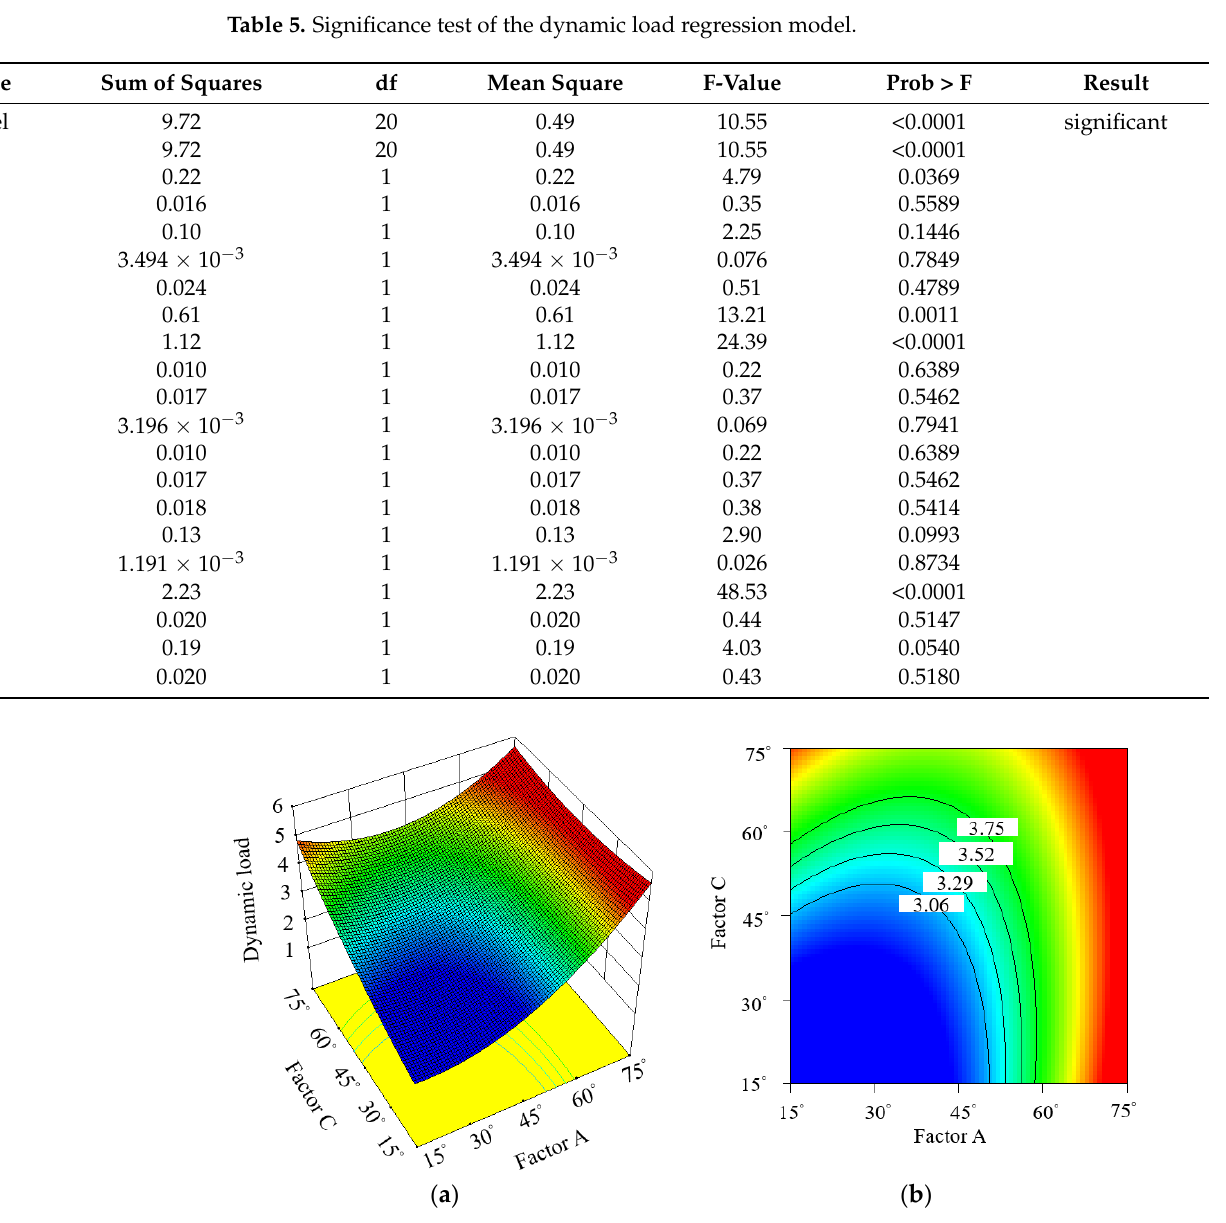
Figure 9. Response surface diagram and contour map of factor A and C on interaction of dynamic load. ( a ) Response surface diagram; ( b ) contour map. The four contour lines mapped on the bottom of Figure 9a correspond to the four types of dynamic load in Figure 9b.